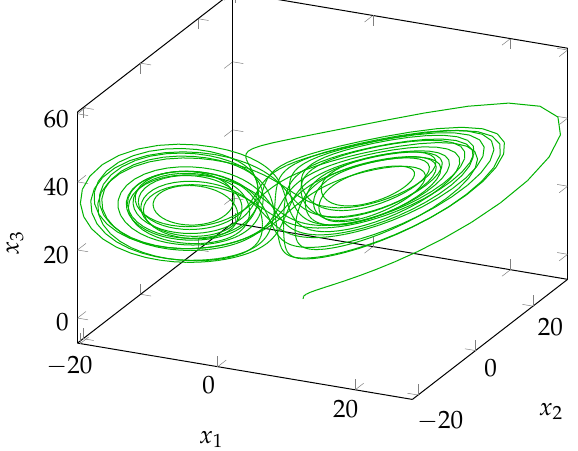
1.7, and x 4 = 5. Plot of − −